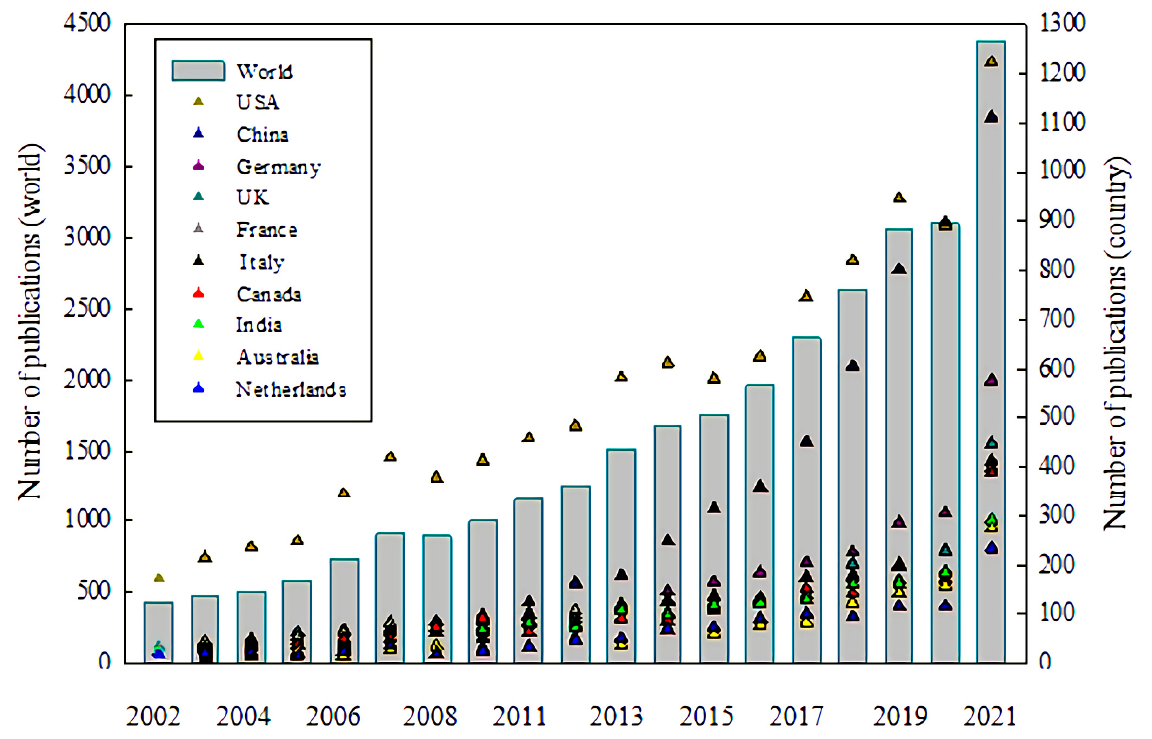
Figure 1. Comparison of publication counts from the top 10 countries and total publication counts globally, 1999–2021.